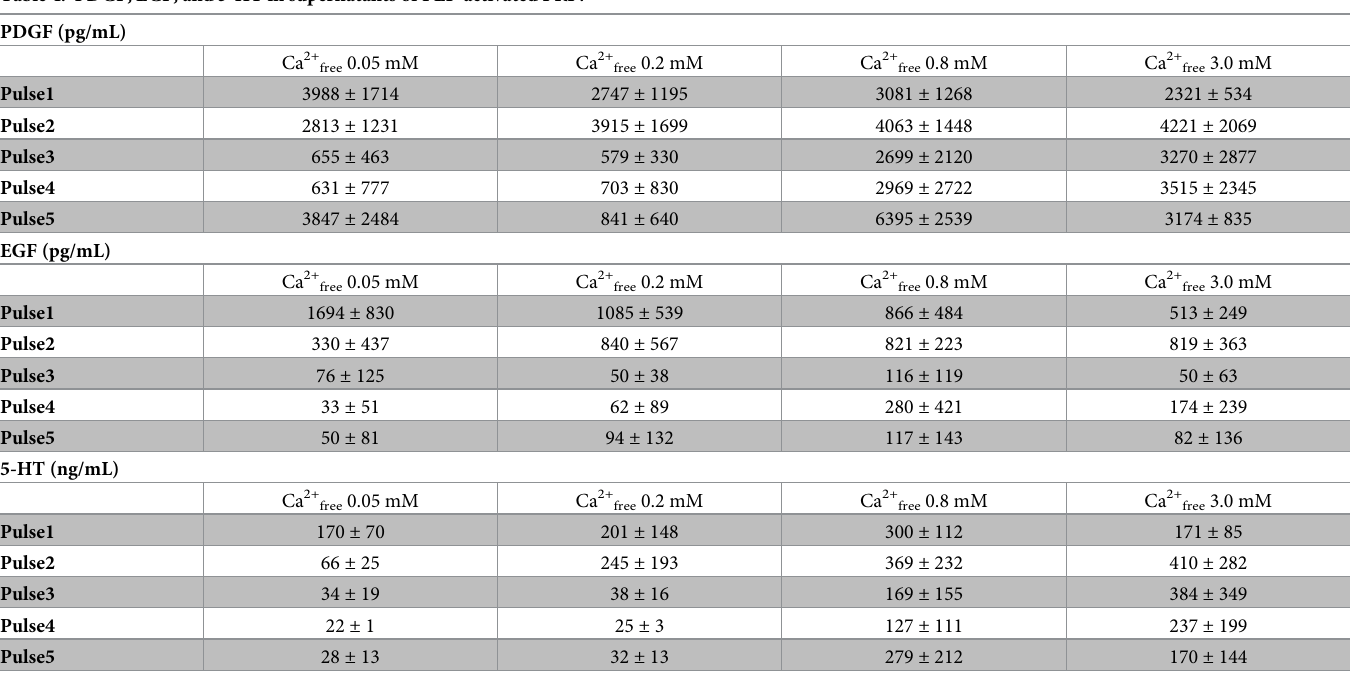
Results shown are means ± SD, n = 3. Abbreviations: EGF, epidermal growth factor; 5-HT, serotonin; PDGF, platelet-derived growth factor; PEF, pulse electric